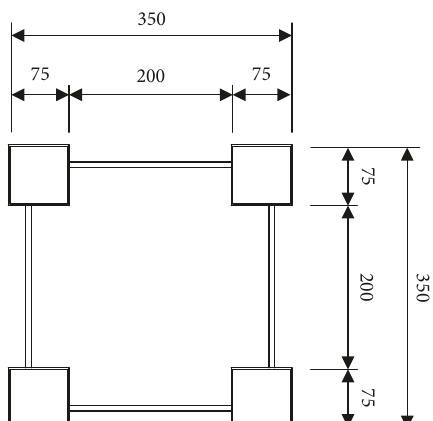
Figure 3: Design diagram of the ISSCC column.